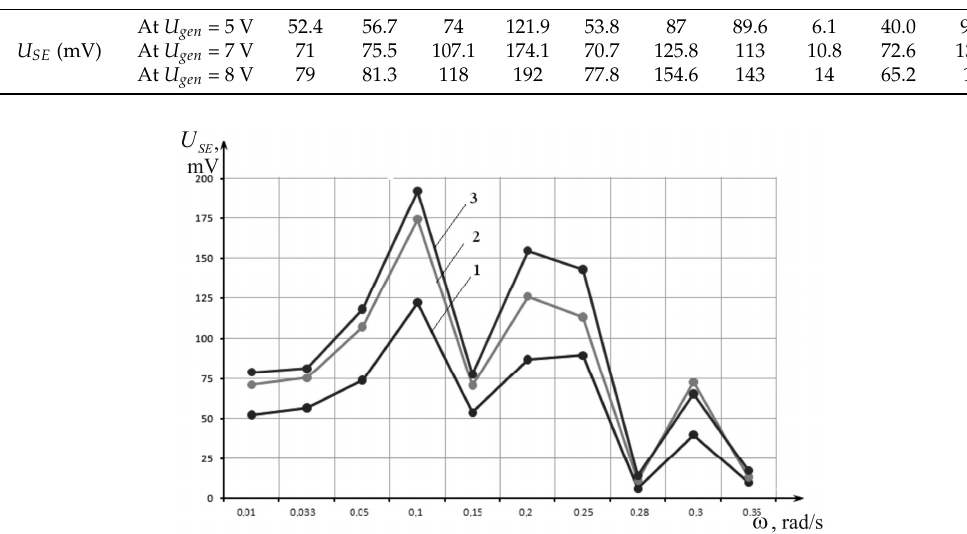
Figure 7. Dependence of SE output voltage on vibration table oscillation frequency at different excitation voltages: 1— U SE = ψ ( ω ) at U gen = 5 V; 2— U SE = ψ ( ω ) at U gen = 7 V; and 3— U SE = ψ ( ω ) at U gen = 8